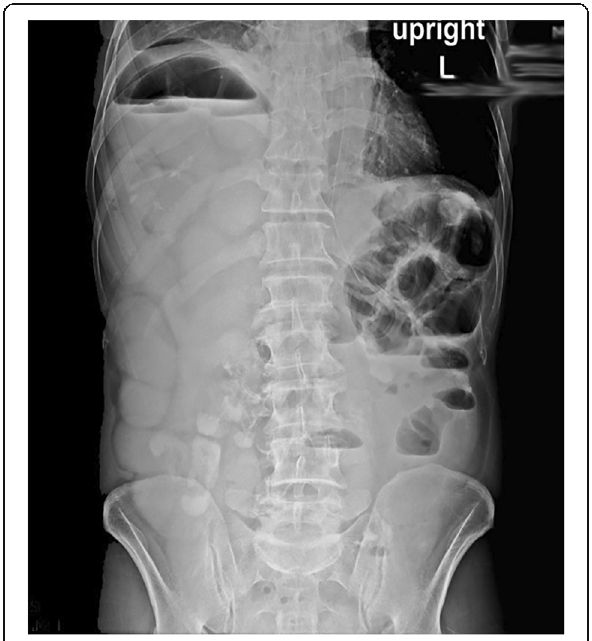
Fig. 1 Abdominal X-ray: multiple air-fluid level and air above the liver on the right